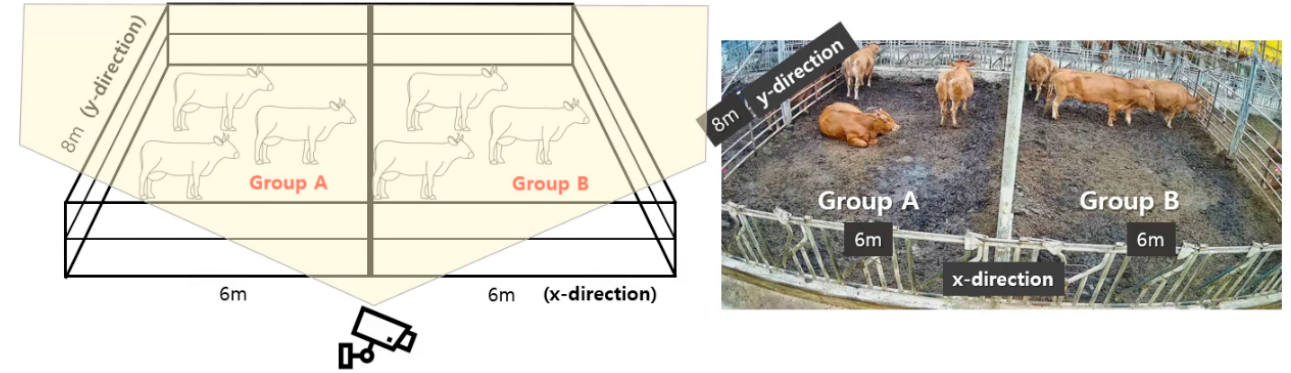
Figure 8. Environment and image of a real barn.